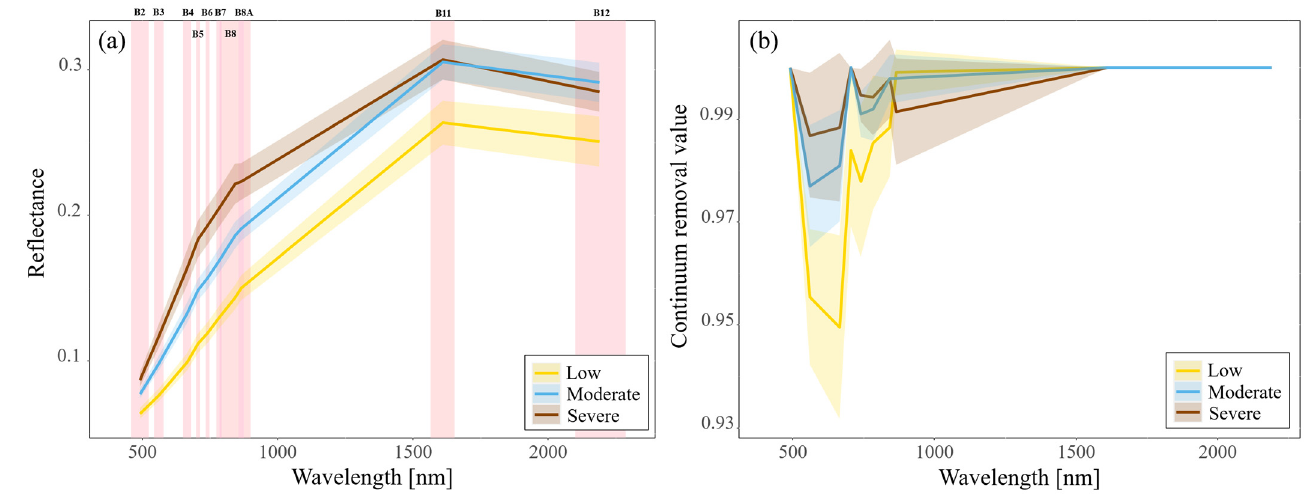
Figure 7. Sentinel-2-based mean spectra of three soil erosion intensity classes. ( a ) Raw spectra and ( b ) continuum-removed reflectance. Shaded areas represent standard deviations from the mean. Sentinel-2 band width and positions are indicated in the left figure.